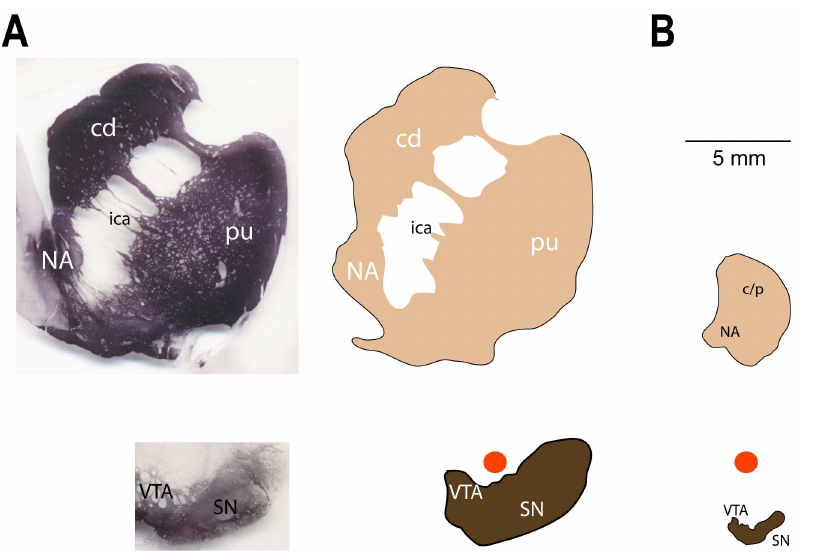
Figure 11. Monkey and rat striatum and VTA/SNc drawn to the same scale. Outlines of representative frontal sections from monkey and rat, striatum and VTA/SN. (A) Photomicrographs (left) of monkey tyrosine hydroxylase (TH) stained sections sized to the scale bar dimensions in B. Territory of monkey (right) striatum and VTA/SN based upon TH sections. (B) Outlines of dopamine neuron cell bodies and terminals in the rat VTA/SN (bottom, plate 43) and striatum (top, plate 17) from Paxinos and Watson atlas [50] estimated using the AChE stains. Circles above VTA/SN are each 1 mm diameter. Approximate area ratios (monkey:rat): striatum including ica=8.6:1, VTA/SN=11.2:1. NA - nucleus accumbens, cd - caudate, pu - putamen, ica - internal capsule, c/p - combined caudate/putamen.